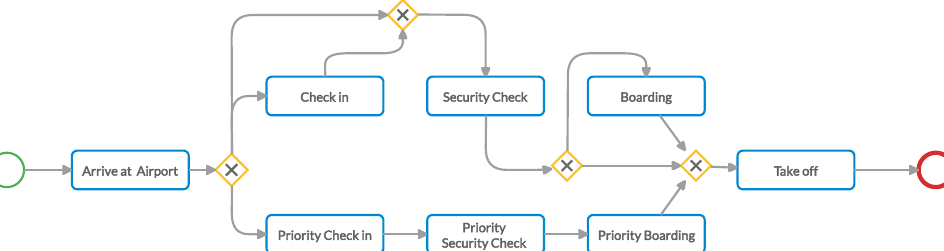
Figure 1. Process model discovered from L 1